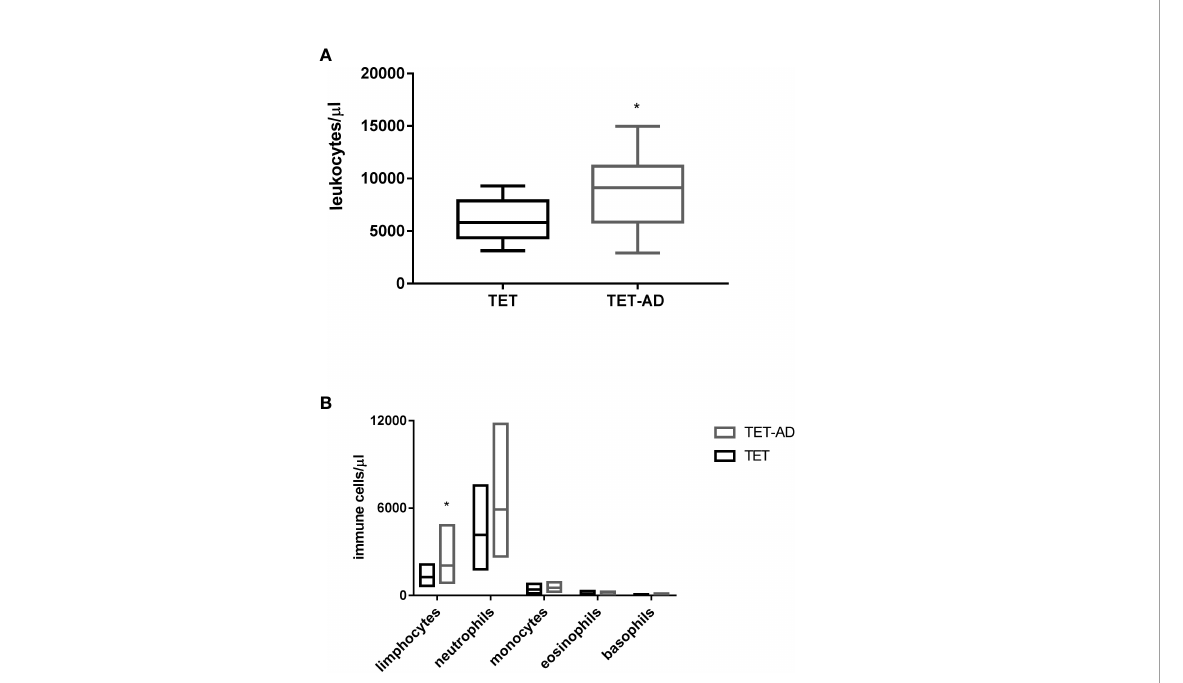
FIGURE 1 Leucocyte and immune cell subset counts in thymoma patients. Blood samples collected from patients with TETs and TET-AD, both with GS, were processed for blood cell count analysis. The number of leucocytes (A) and the number of lymphocytes, neutrophils, monocytes, eosinophils and basophils (B) expressed in leucocytes/µl and immune cell/µl respectively is reported for both groups of patients. Results are represented as mean values ± SD in box plots. Unpaired parametric two tailed t test was performed for the analyses of leucocytes, neutrophils, monocytes and basophils. Mann-Whitney test was used for the analyses of lymphocytes and eosinophils *p <